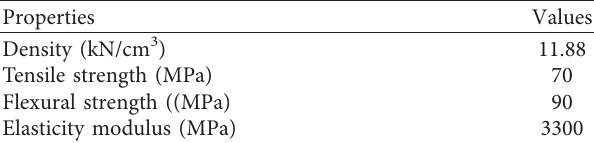
Figure 3: *e angle of repose of the sand. Table 2: Material properties of the plexiglass sheet.